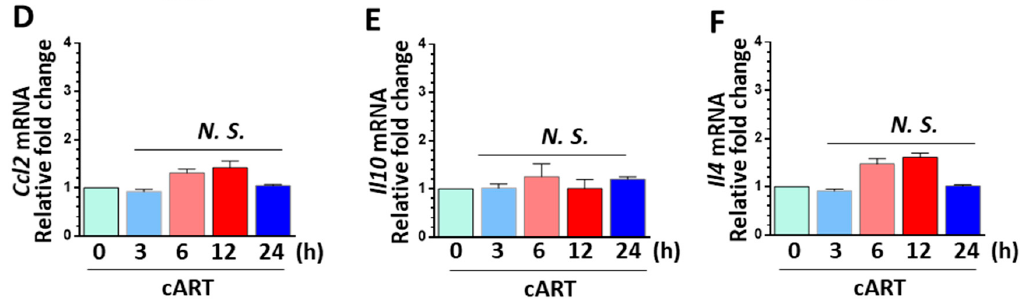
Figure 4. Exposure of microglial cells to cART resulted in cellular activation. rPMs were seeded into six-well plates and treated with cART (5 µ M each of TDF, FTC, and DTG) for the indicated time periods. Total RNAs were extracted for the detection of pro- and anti-inflammatory mediators. ( A – C ) Representative bar graphs showing cART-mediated time-dependent increase in the mRNA expression of pro-inflammatory cytokines interleukin 1 beta (Il1b), interleukin 6 (Il6), and tumor necrosis factor (Tnf) in rPMs. ( D – F ) cART exposure had no e ff ect on the expression of C-C motif chemokine ligand 2 (Ccl2) and anti-inflammatory cytokines (Il10 and Il4) in rPMs. Data is from three independent experiments and is represented as means ± SEM using one-way ANOVA. *, p < 0.05 vs. control.